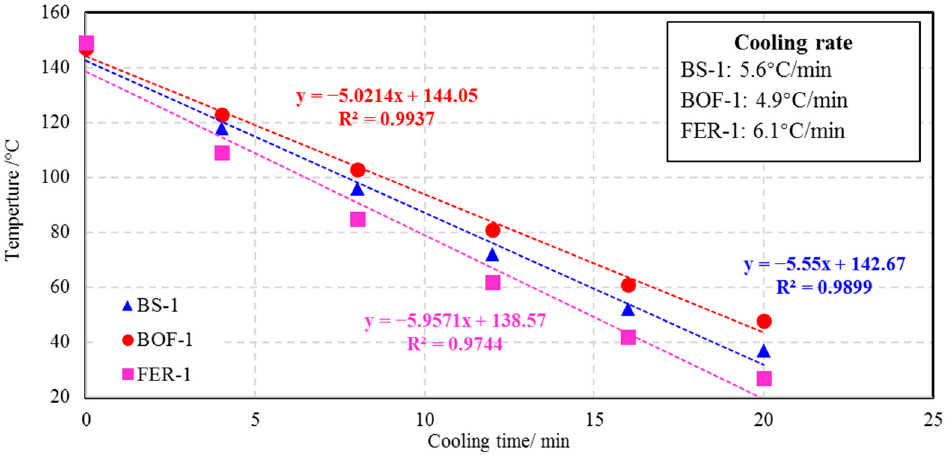
Figure 4. Cooling curves of different aggregate.